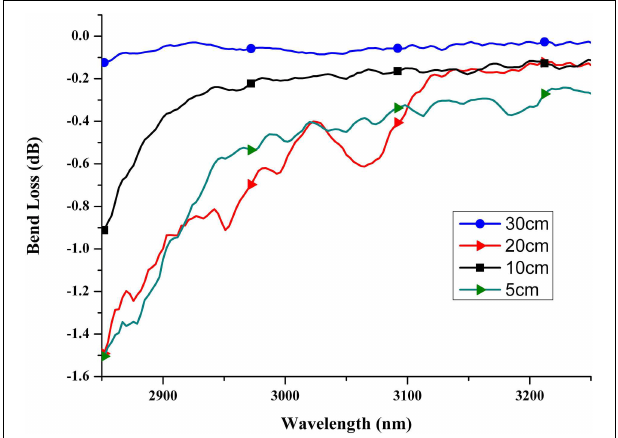
FIGURE 3 | (A) SEM image of the NCF with a 43 µ m core designed for the 1 µ m regime. (B) SEM picture of the capillary forming the negative curvature of the fiber core wall and the cladding nodes (white circles) [50].